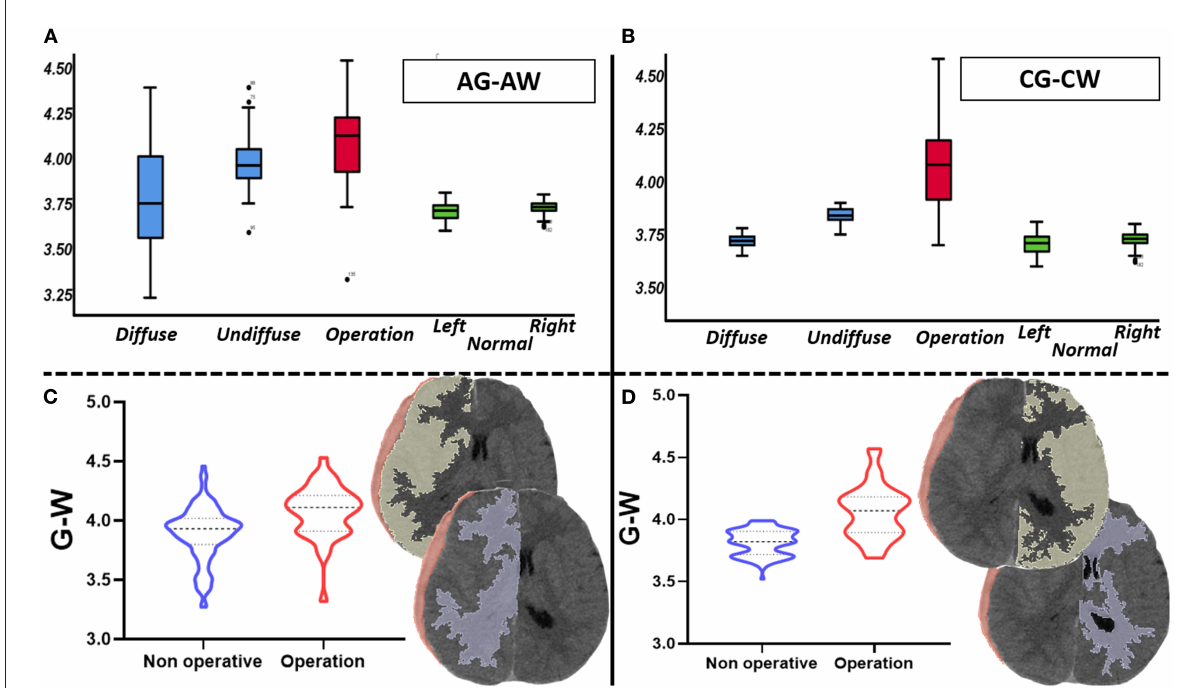
FIGURE2 Comparison of gray and white matter’s density difference value (total n = 156, non-surgical group n = 118, surgical group n = 38). (A) It mainly describes the distribution of the density differences between gray and white matter in the affected side of each group. (B) It mainly describes the distribution of the density differences between gray and white matter in the contralateral side of each group. (C) It shows the difference of the density differences between gray and white matter in affected side between surgical group and non-surgical group. (D) It shows the difference of the density differences between gray and white matter in contralateral side between surgical group and non-surgical group.